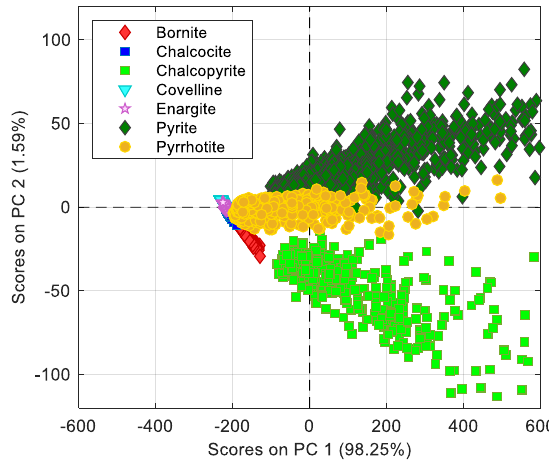
Figure 5. PC1 – PC2 scores from PCA applied to the mean centered data matrix. Figure 5. PC1–PC2 scores from PCA applied to the mean centered data